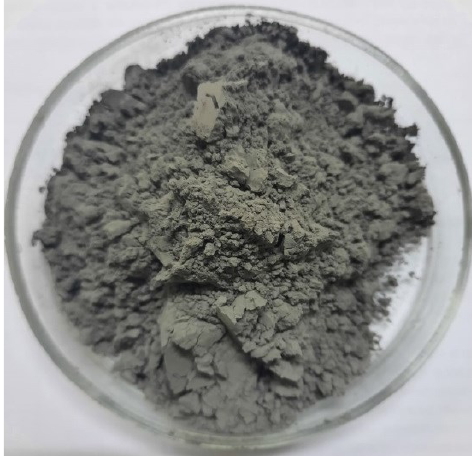
Figure 15. Appearance of the aluminosilicate component.